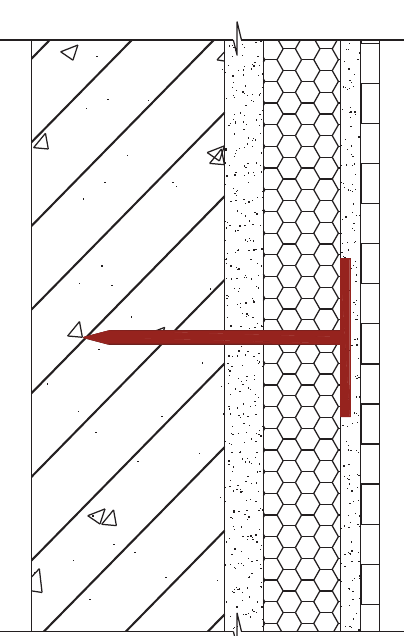
Figure 9: Anchor bolt anchoring diagram.